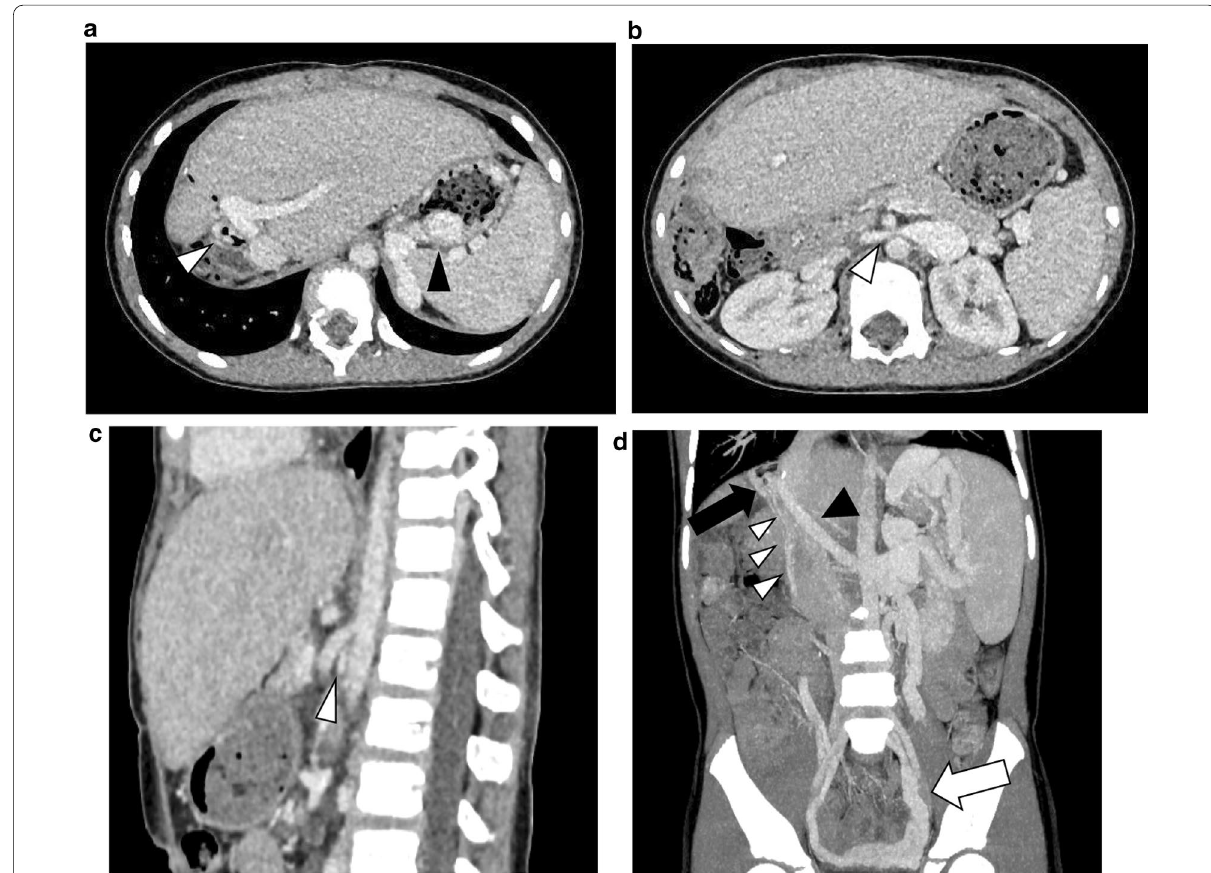
Fig. 2 AB Axial CT image. a The white arrowhead shows the jejunal varices. The black arrowhead shows the gastric varices. b The white arrowhead indicates compression of the LRV between the SMA and the Ao. c Sagittal CT image. The white arrowhead indicates the narrow angle between the SMA and the Ao. d Multiplaner reconstruction CT image. The black arrow shows the varices of the RY jejunum. The white arrowheads indicate collaterals to the RY varices from the SMV. The black arrowhead indicates the patent RPA. Pelvic vein congestion (white arrow) is suggestive of increased venous pressure via the dilated gonadal vein. Ao abdominal aorta, CT computed tomography, LRV left renal vein, RY Roux-en-Y, SMA supramesenteric artery, SMV supramesenteric